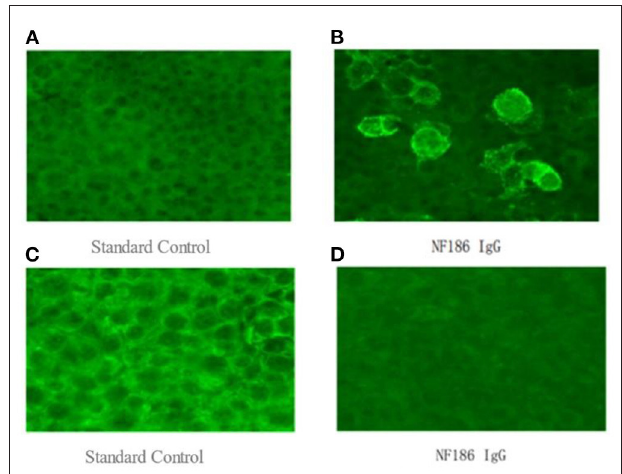
FIGURE 1 | (A,B) a serum antibody test (Cell-based assay), which was examined on July 26, 2021, displayed anti-NF186 antibodies IgG 1:100. (C,D) the anti-NF186 antibodies IgG, which was examined on August 12, 2021, was negative after rituximab (RTX) treatment.